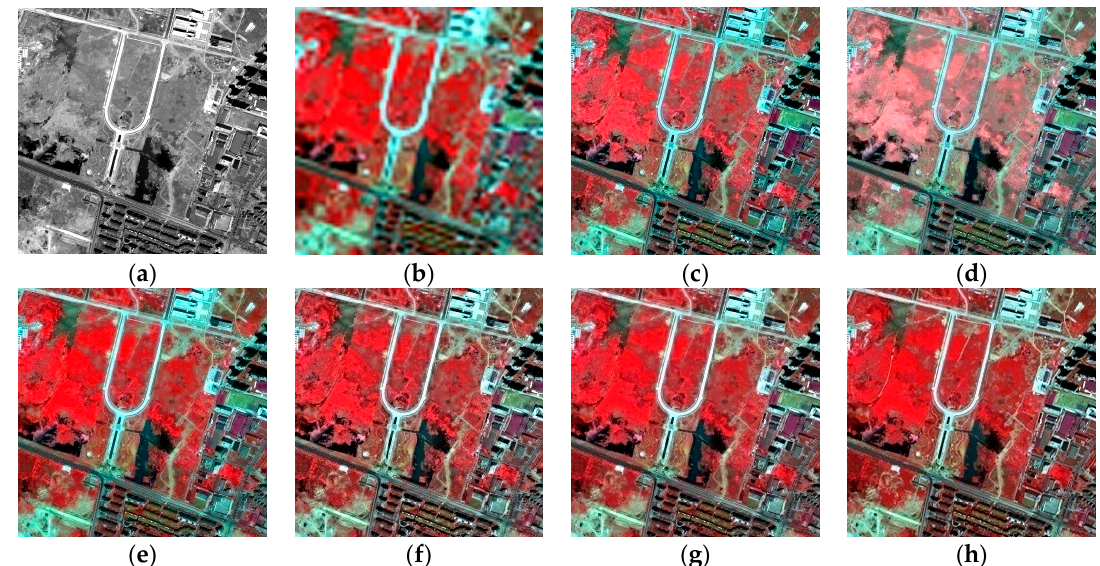
Figure 3. Fusion results of IKONOS experiment. ( a ) PAN image; ( b ) MS image; ( c ) GS fusion result; ( d ) PCA fusion result; ( e ) AIHS fusion result; ( f ) AWLP fusion result; ( g ) proposed fusion result; ( h ) original MS image.